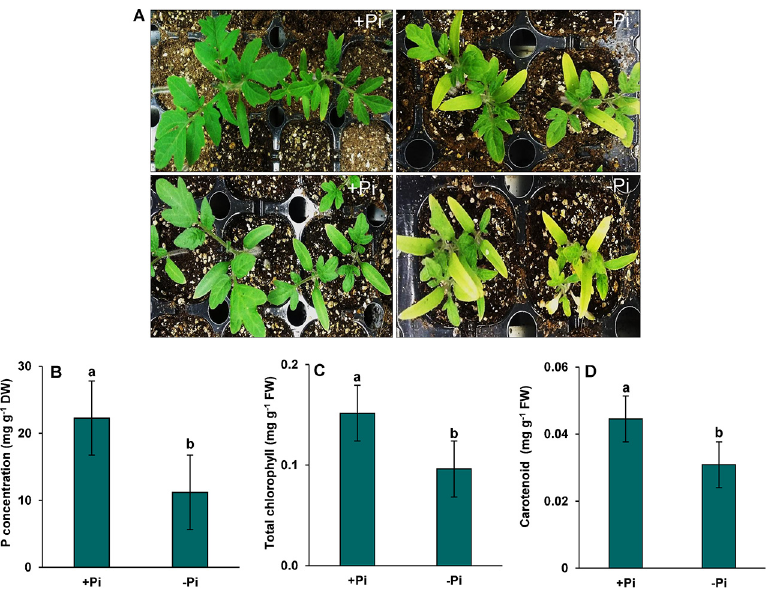
Fig 1. Phenotypic and physiological indices in leaves of tomato ( Solanum lycopersicum L.) to Pi starvation. One week after germination tomato plants were supplied with sufficient Pi (1 M KH 2 PO 4 ) or deficient Pi (0 M KH 2 PO 4 ) for 10 days. (A) Phenotypic differences (B) Pi concentration (C) total chlorophyll and (D) carotenoid content. Vertical bars indicate Mean ± SE of the means for n = 3. Means denoted by the different letter are significantly different at P (cid:3) 0.05 according to the Tukey ’ s studentized range test.